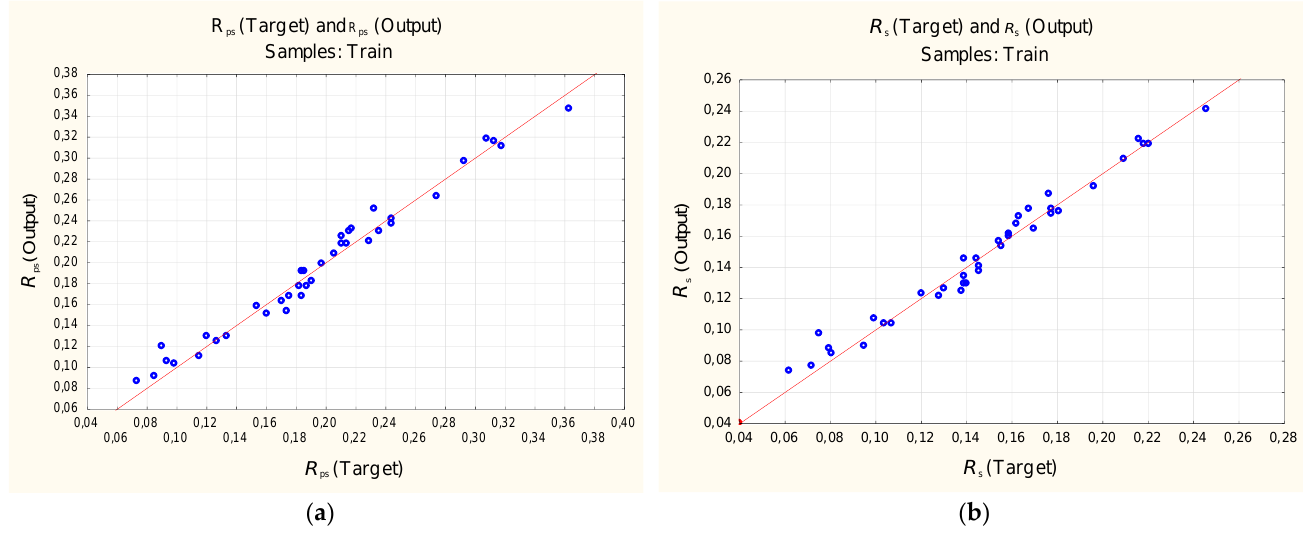
Figure 9. Scatter plot of the training sample (exponential activation function): ( a ) Return on sales R ps ; ( b ) Return on sales R s .